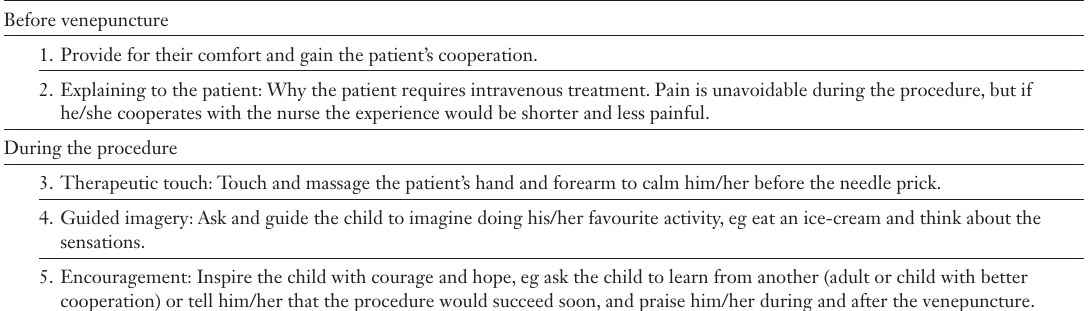
Table 1 Psychological inter- vention scheme in the intervention